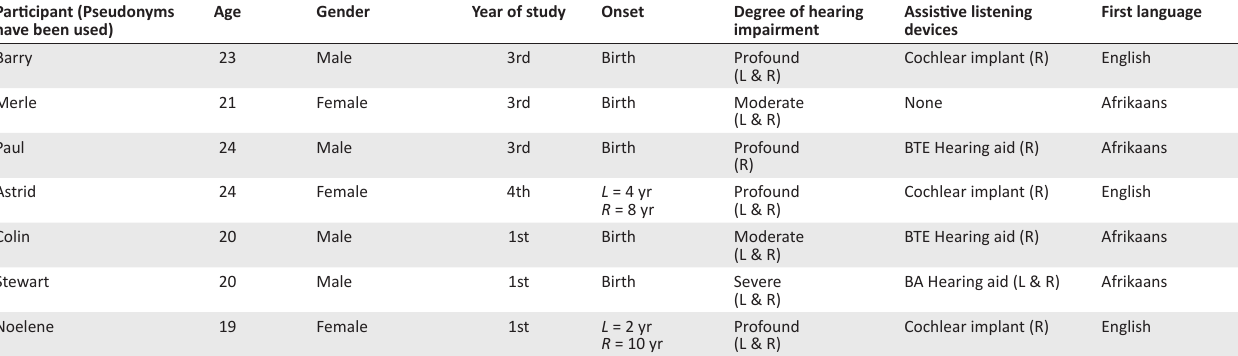
TABLE 1: Biographical data for each student participant. Participant (Pseudonyms Age Gender Year of study have been used)